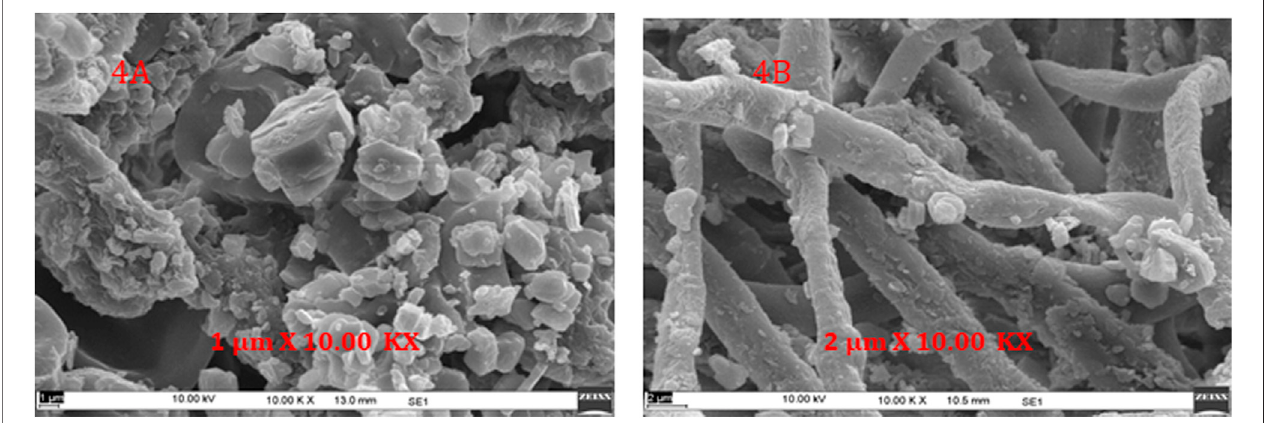
FIGURE 4 | Spatial localization of metabolites using SEM, Scanning electron microscope images of sample after grinding employing mixer grinder (A) Cortex powder (B) Medulla pieces.